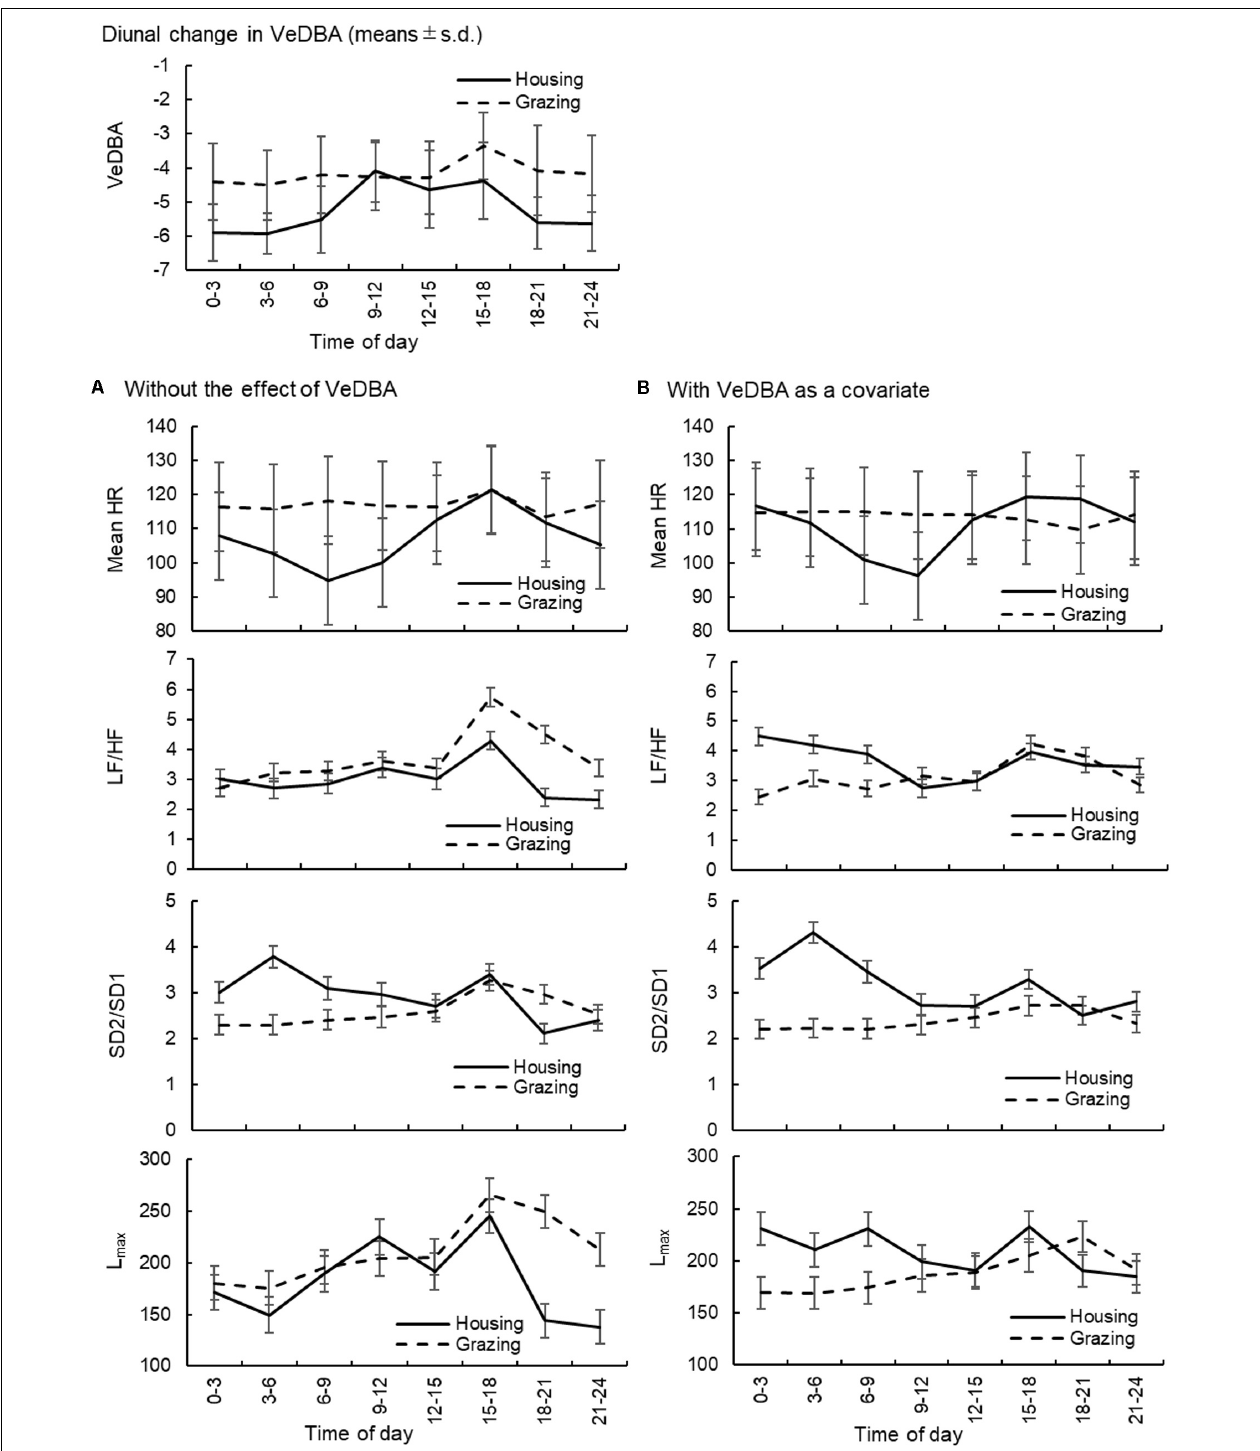
FIGURE 3 | Diurnal changes in VeDBA and the effects of the change in time of day on the mean HR and HRV parameters (LF/HF, SD2/SD1, and L max ) in sheep. (A) The changes in the mean HR and HRV parameters without considering the effect of VeDBA and (B) those when the effect of VeDBA was included as a covariate. The VeDBA plots are presented as arithmetic mean and standard deviations, and plots for the other parameters are presented as least squares mean and standard errors. VeDBA, natural logarithmically transformed vectorial dynamic body acceleration ( g ); HR, heart rate; HRV, heart rate variability; LF/HF, the ratio of normalized power of the low frequency band to the high frequency band; SD2/SD1, the ratio of standard deviation of long-term HRV measured from axis 2 of Poincaré plot to axis 1 in Poincaré plot; L max , the length of longest line of recurrent points (beats).